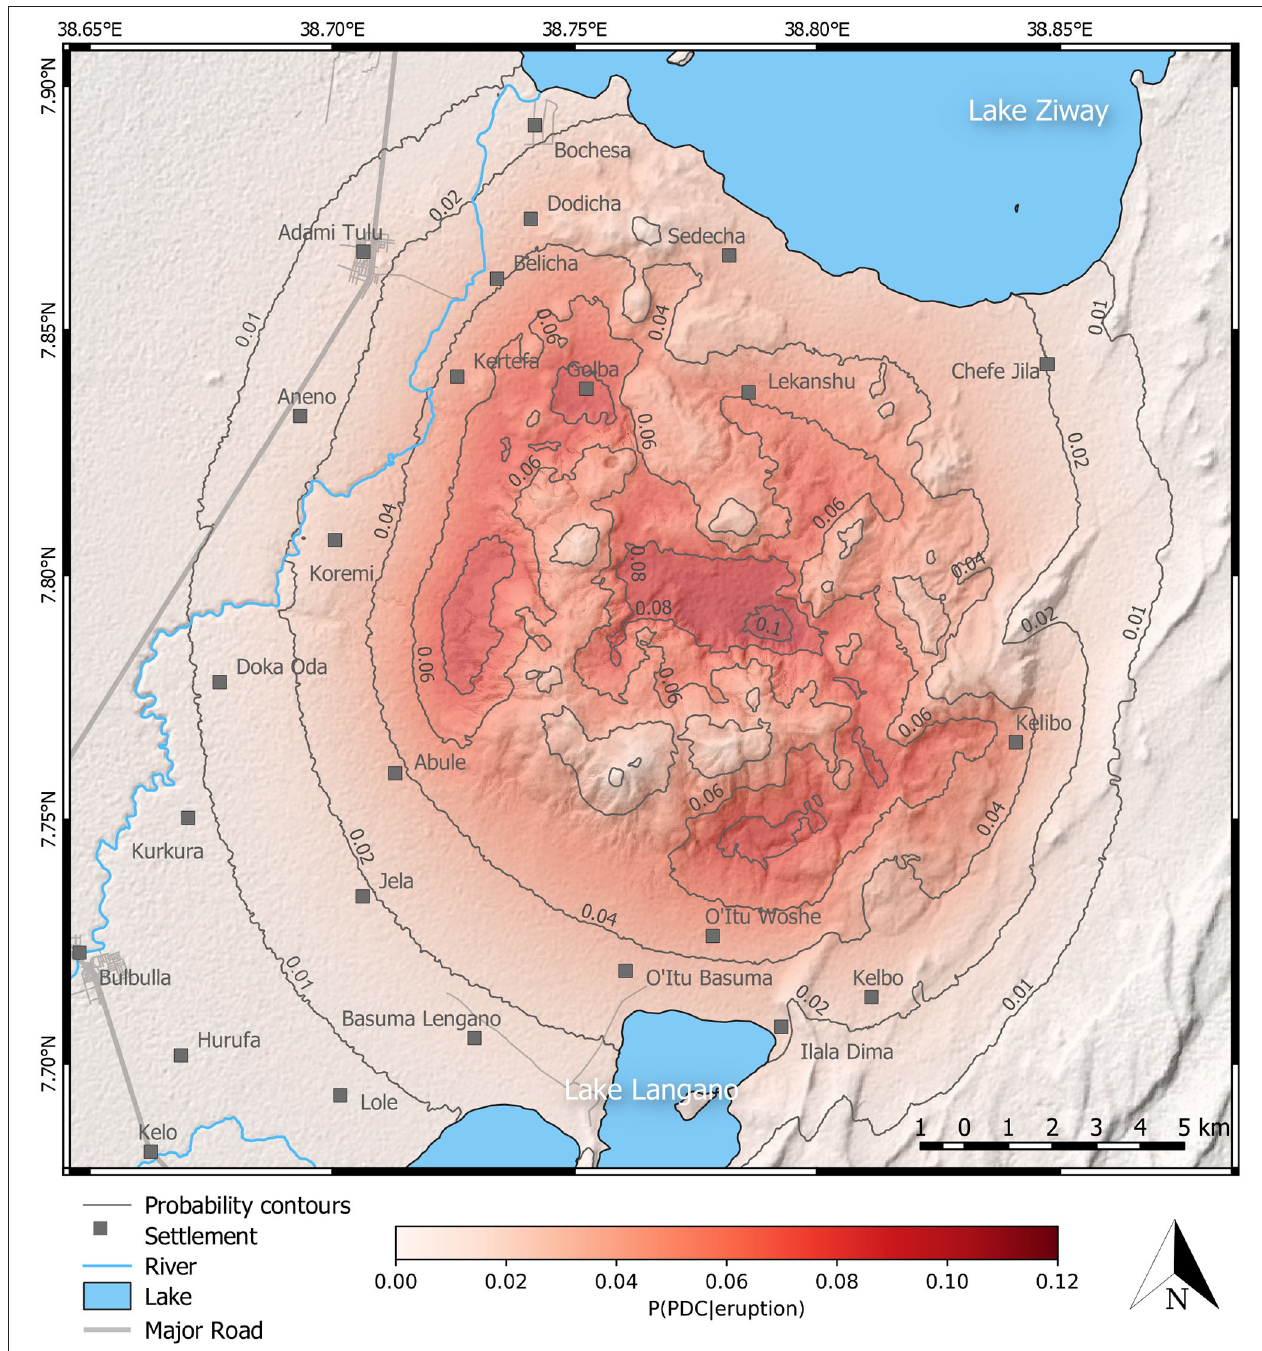
FIGURE 10 | Result of the energy cone modeling showing the conditional probability of PDC inundation around Aluto given an eruption P(PDC provided at a 30 m resolution and has a precision of 0.01 (1%). Apart from the bounding 0.01 (1%) contour, contours of probability are in increments of 0.02 (2%). Settlements names and locations are sourced from the Ethiopian mapping agency. Roads are sourced from OpenStreetMap. High resolution (2 m) LiDAR DTM of Aluto is from Hutchison et al. (2014). Lower resolution (1 arc second) STRM DTM of surrounding regions is from NASA (2014).